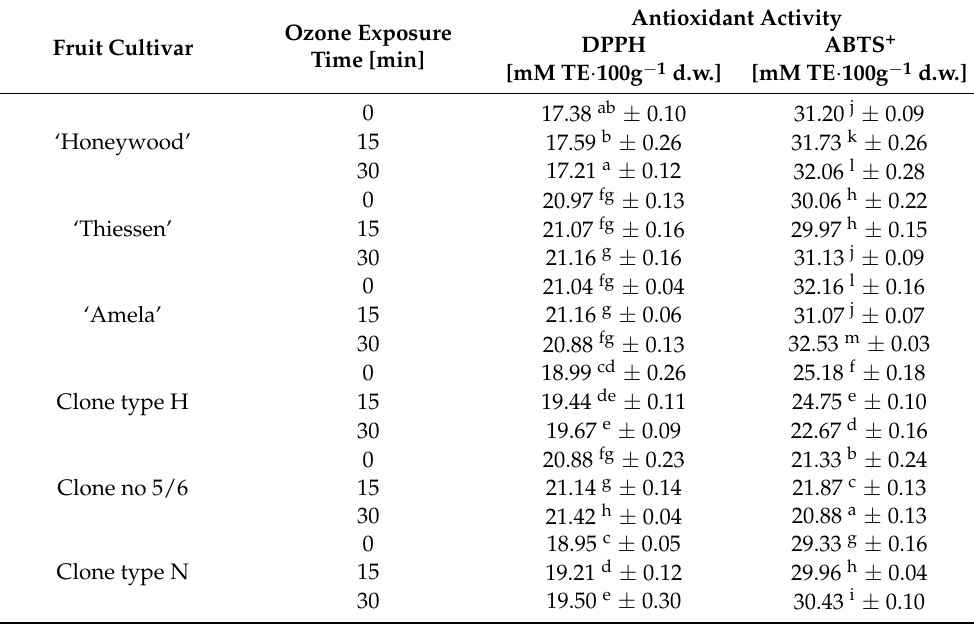
Table 4. The content of the antioxidant activity of the Saskatoon berry.